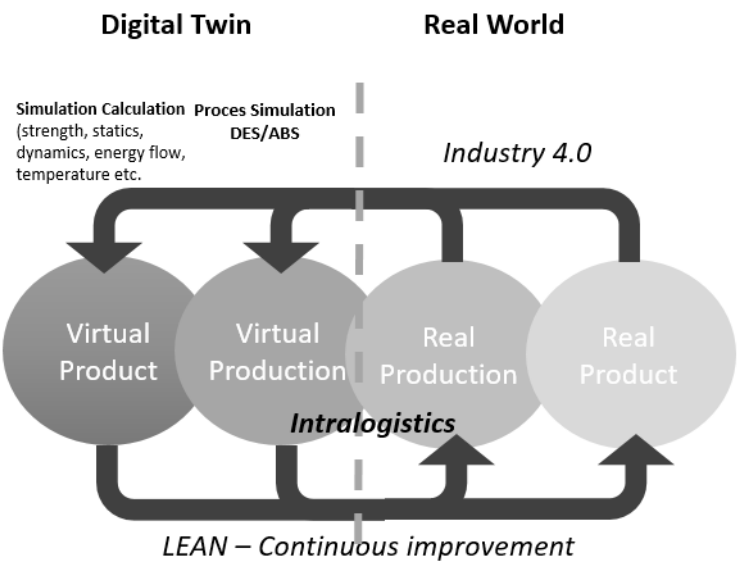
Figure 3. Industry 4.0 and Lean connection in the context of Digital Twin—based on [16].